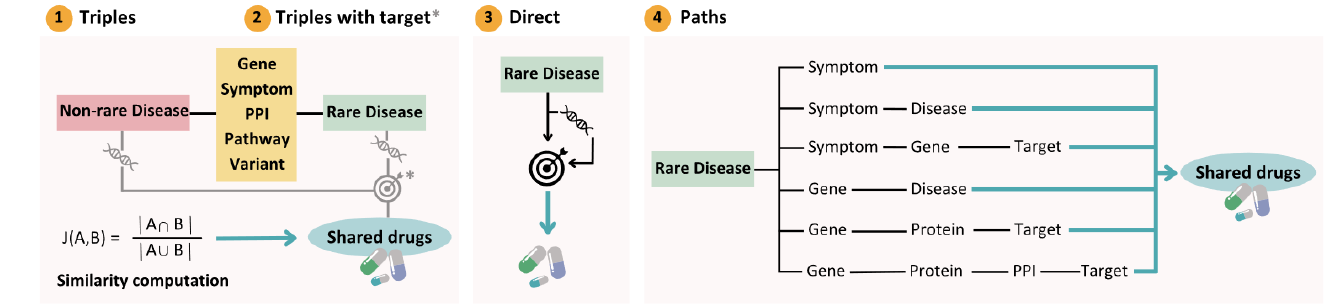
Figure 4. Summary of the four computational methodologies applied to obtain drug repositioning in rare diseases.